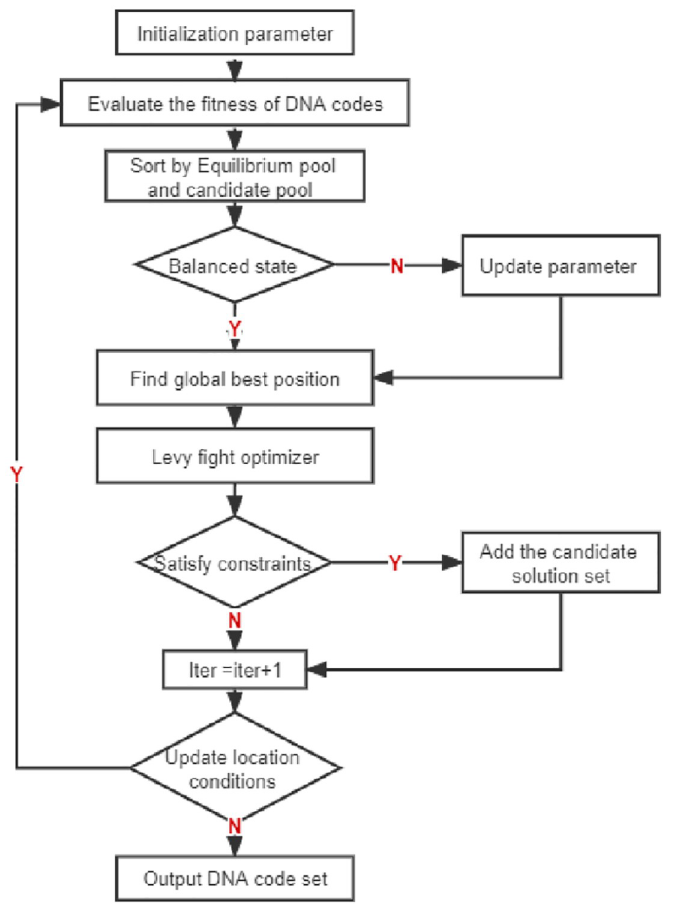
Fig 1. Flow chart of LEO algorithm.